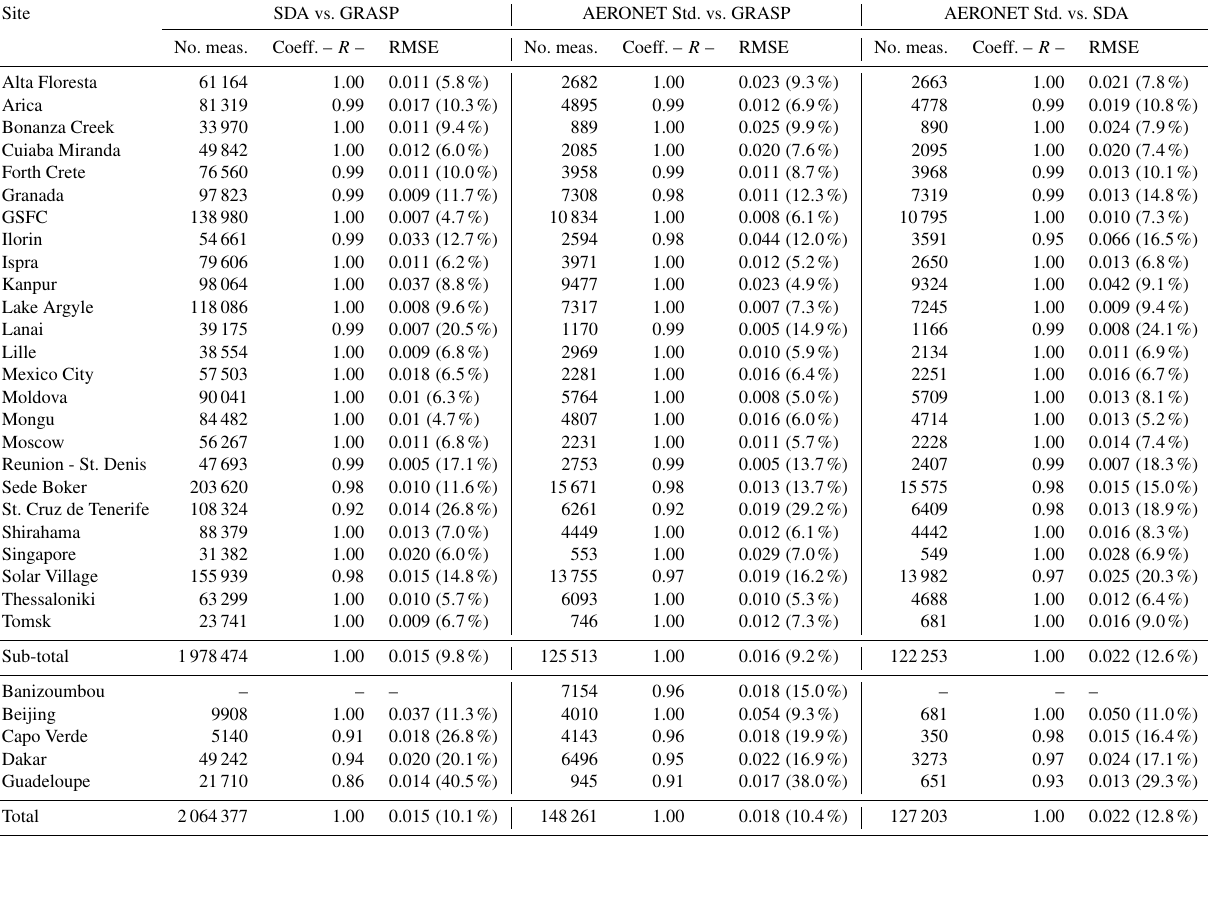
Table 4. Comparisons of τ f ( 500 ) values computed with three different algorithms (AERONET, GRASP-AOD and SDA) for sites and periods indicated in Table 1. The first column depicts the site name, and the rest of the columns indicate the number of coincident data points and the values of the correlation coefficients and RMSE (and RMSRE enclosed in parentheses) of the comparisons between the methods. Site